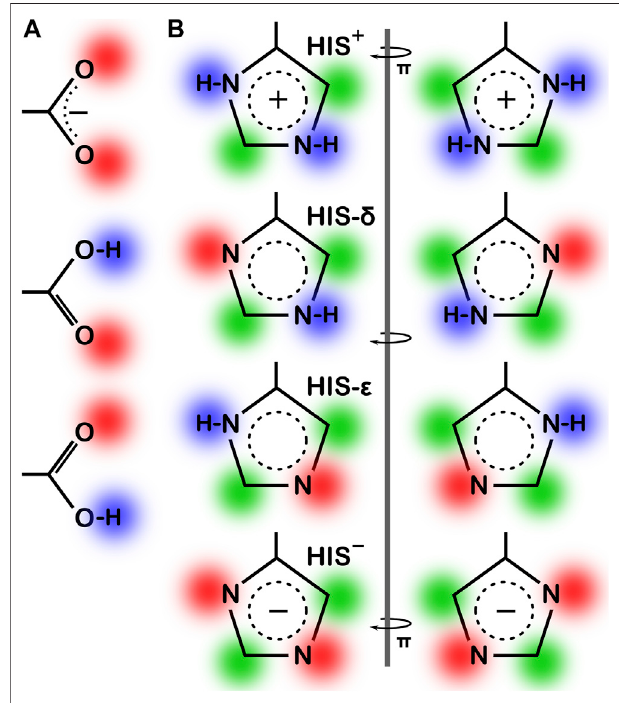
FIGURE 3 | Various possibilities for ASP, GLU and HIS ionization/ rotameric states. (A) ASP, GLU,and (B) HIS sidechainfunctionalgroups. Red (cid:1) Lewis acid, blue (cid:1) Lewis base, green (cid:1) hydrophobic. Note that “ ring fl ips ” of HIS present distinct patterns for